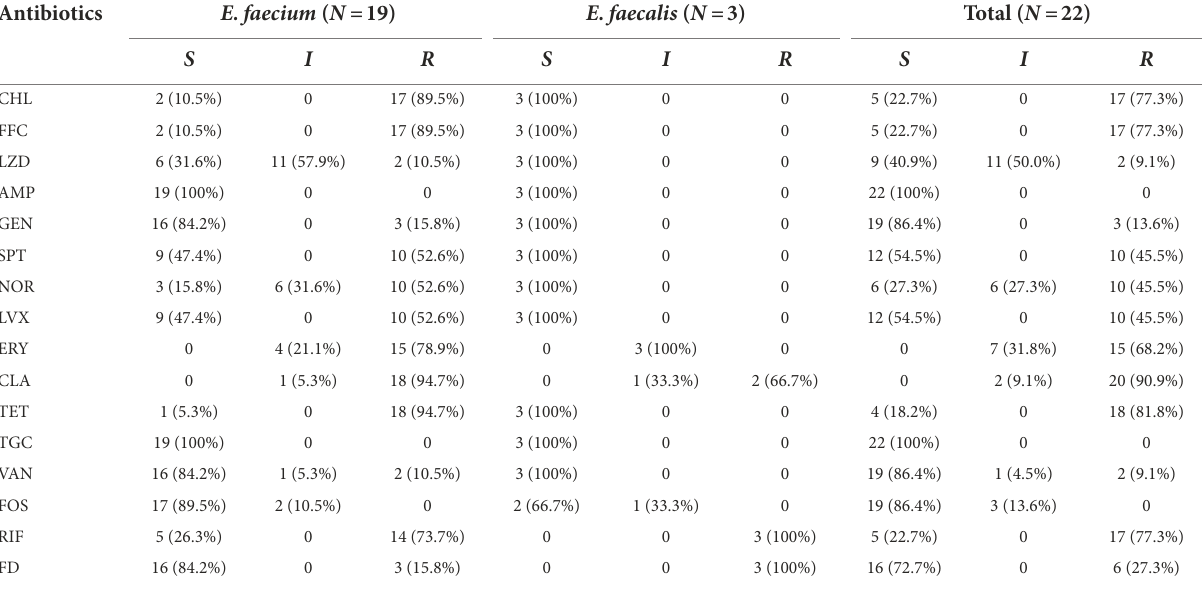
TABLE 2 Characterization of the susceptibility of 22 Enterococcus isolates to 16